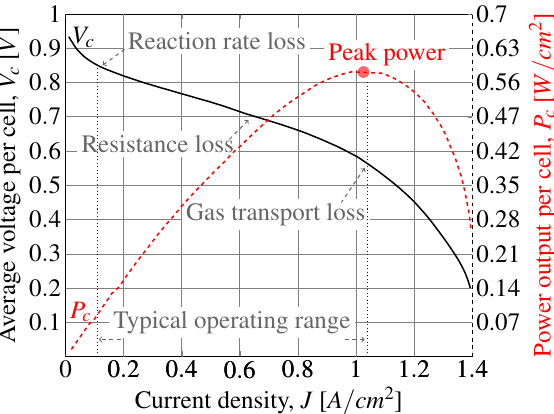
Figure 1. Output voltage of a PEMFC as a function of the current density, data according to [6]. Two electric architectures in FCHVs are of interest for future applications. Figure 2a illustrates the system in which a boost converter connects the fuel cell to the DC bus [5,7]. The motor interfaces the DC bus via a bidirectional DC–AC converter. In addition, this architecture uses a bidirectional buck–boost converter in front of the battery. Figure 2b illustrates an alternative solution, where the output terminals of the fuel cell are connected directly to the DC bus [5,7]. However, depending on the state of charge of the battery and the load-dependent fuel cell voltage (see the typical operating range in Figure 1), both voltage levels can overlap. For this reason, a bidirectional DC–DC converter is necessary, interfacing both voltage characteristics to enable good cold-start behaviour, flexible power control, regenerative braking, and to avoid dynamic current stress of the fuel cell stack by providing additional traction power during acceleration [8–10]. For these reasons, optimising the bidirectional DC–DC converters in front of the battery is essential for vehicle performance. Basically, three topologies are suitable, the bidirectional CúK, SEPIC/ZETA, and cascaded buck and boost converter. Nevertheless, a previous study [11] demonstrates that in terms of electric stress on the power semiconductors and converter volume, the cascaded buck and boost converter is an appropriate topology for FCHVs to interface the battery to the DC bus. For example, the study in [11] demonstrates that the cascaded buck and boost converter topology reduces the required inductance to a fifth and the capacitance value by 5% compared to the CúK and SEPIC/ZETA converter. As ∼ the inductance relates to the energy-handling capability and, therefore, the volume of the inductor, it indicates that the cascaded buck and boost converter decreases the converter volume for the application of interest accordingly. As the inductor of a DC–DC converter is a major contributor to the overall volume, the bidirectional cascaded buck and boost converter is thus a suitable topology for mobile applications such the